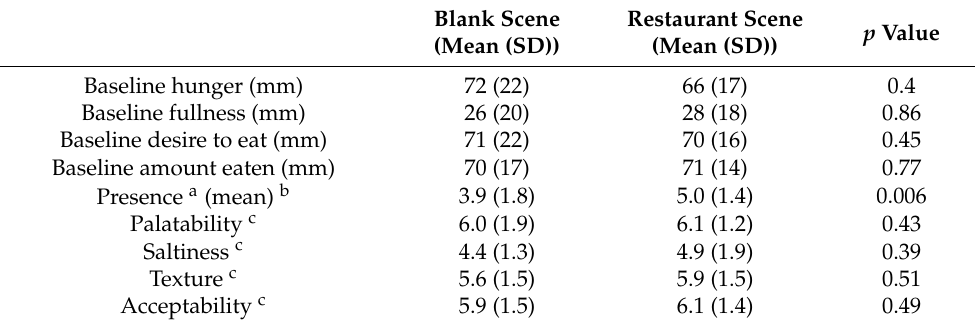
Table 1. The participants’ responses to baseline appetite questions, sense of presence, and sensory characteristics of the test food. N = 15 for all questions in the restaurant and blank scene.